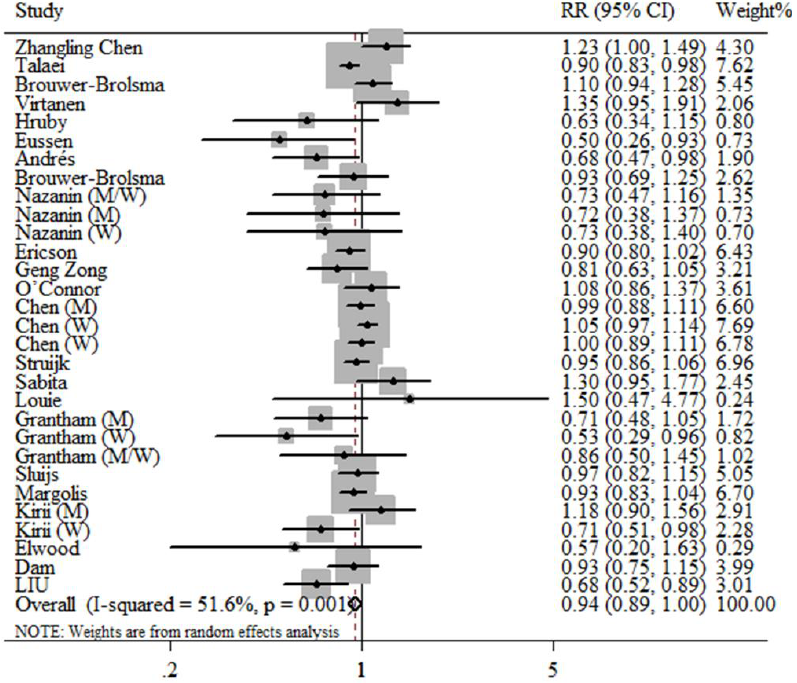
Figure 1. Prospective associations of high vs. low dairy intake with incident type 2 diabetes mellitus (T2DM) of the meta-analysis.